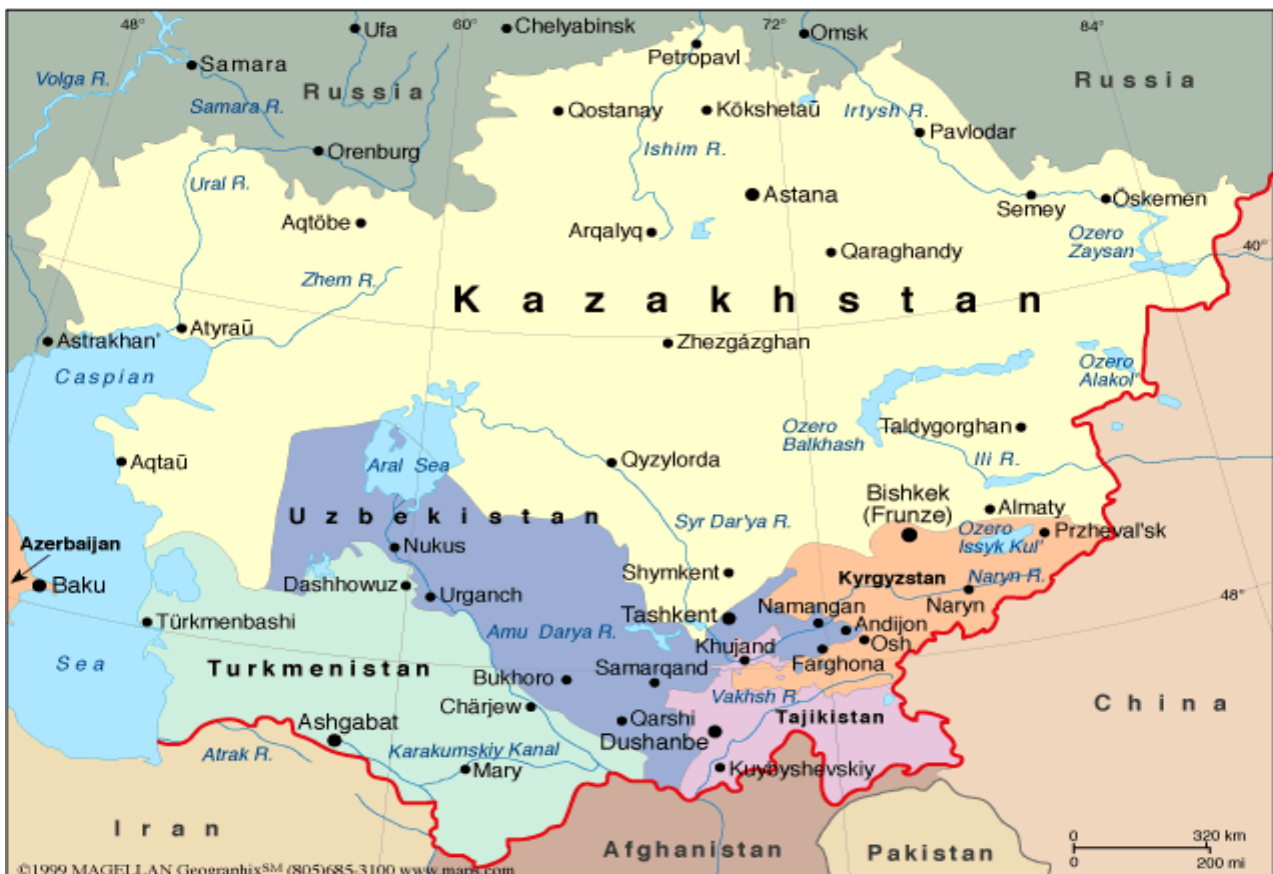
Figure 1: The countries of Central